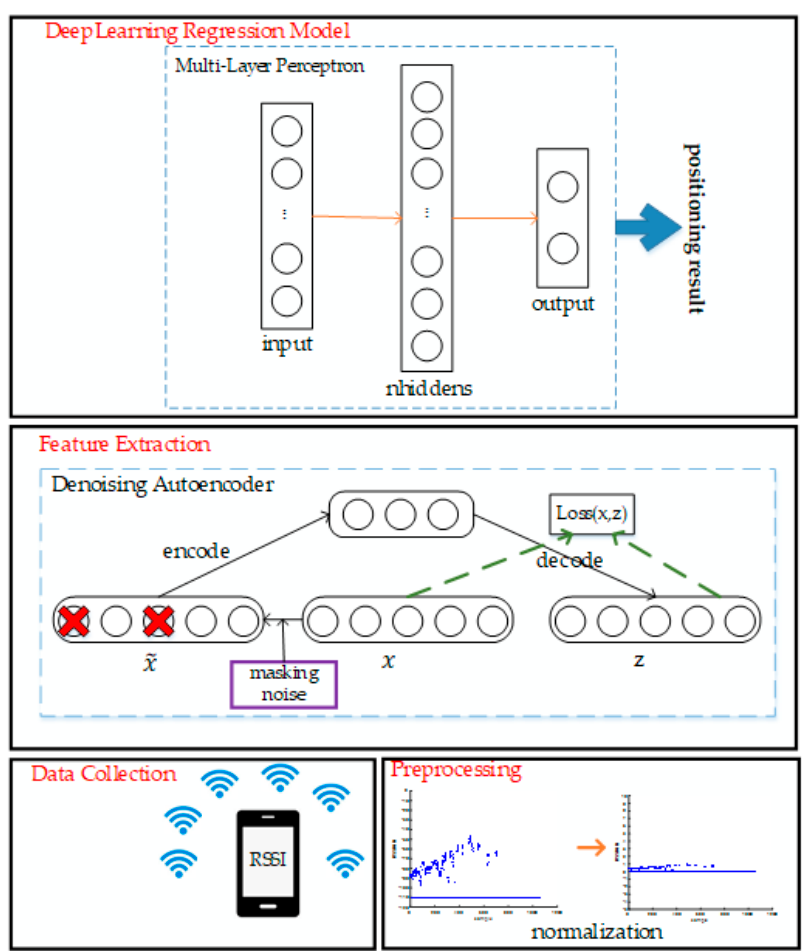
Figure 1. Overall structure of our proposed positioning